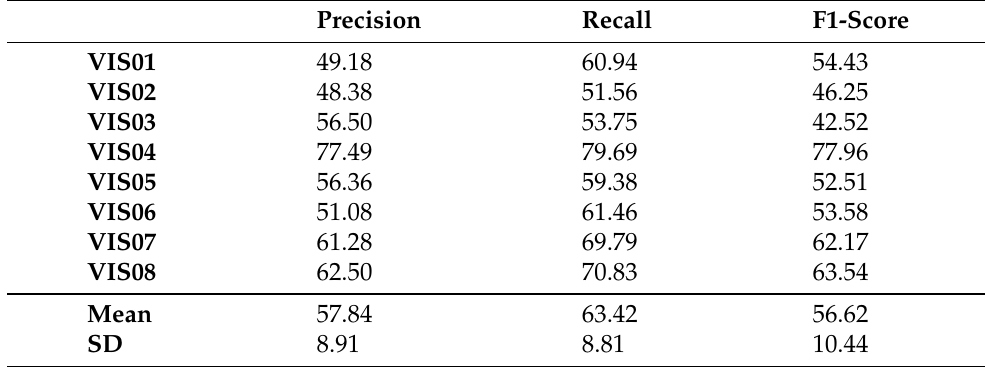
Table 4. Classifier performance (in %) of VIS group without optimal transport.